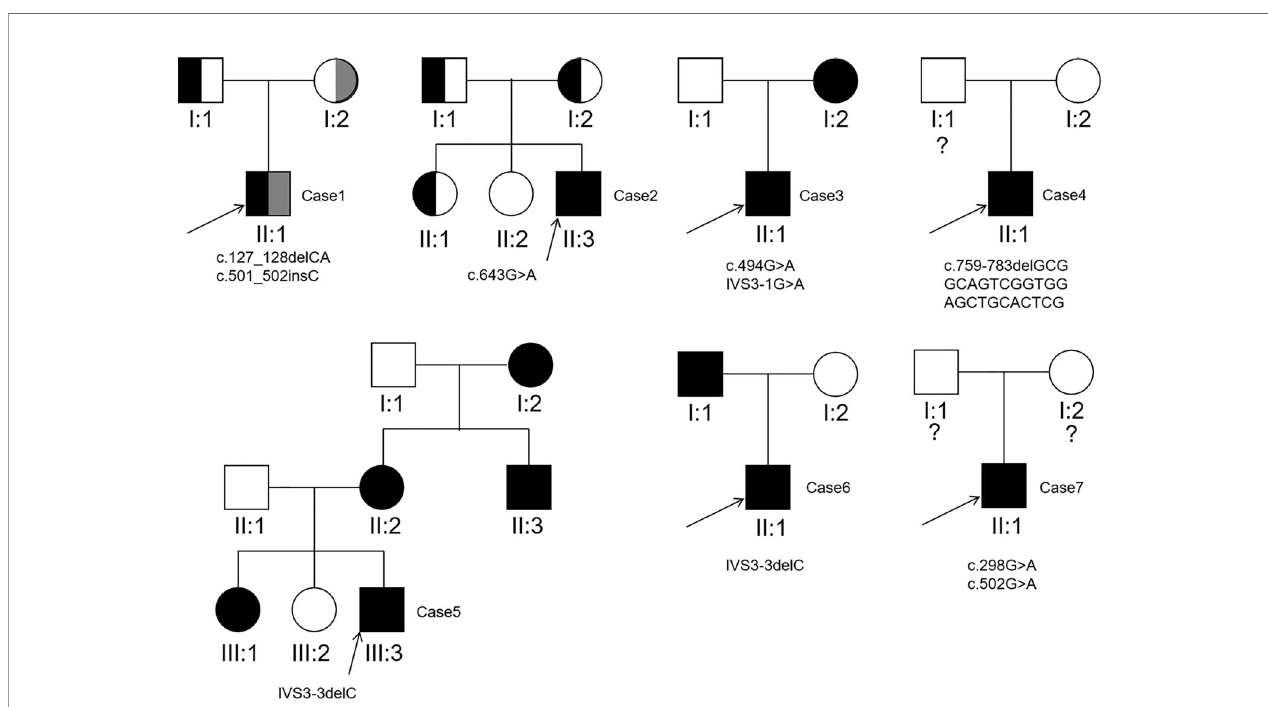
FIGURE 1 | Pedigrees ofthe7familiesdetectedto carrypathogenic AQP2 mutations.Thequestionmarkindicates AQP2 mutationanalysisofthe